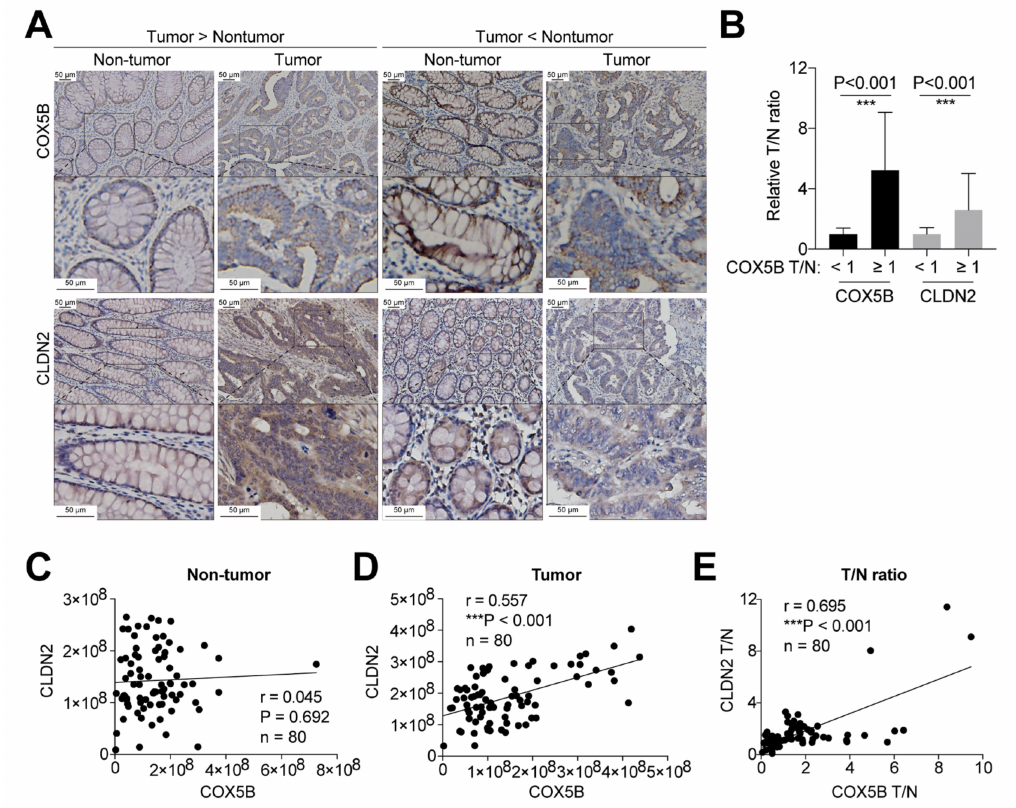
Figure 5. The correlation between COX5B and CLDN2 expression in CRCs patient-derived tissues. ( A ) The representative images of IHC staining of COX5B and CLDN2 in either non-tumor or tumor sections. The staining intensities were obtained and the comparisons between subgroups were summarized in ( B ). ***, p < 0.001. The Pearson correlation of COX5B and CLDN2 intensities in ( C ) non-tumor and ( D ) tumor sections were conducted. ( E ) The COX5B and CLDN2 T/N ratio were correlated using Pearson correlation